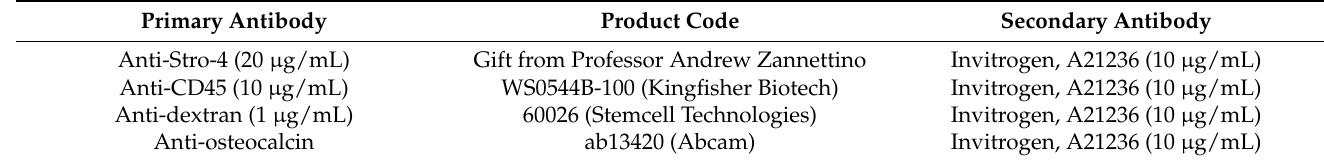
Table 2. Details of the antibodies used for